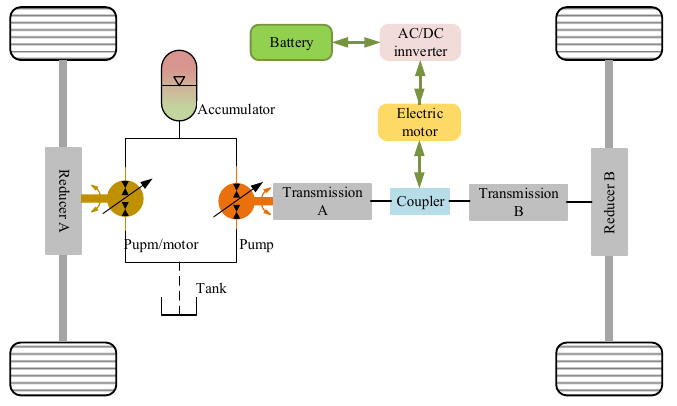
Figure 11. EH3 system in a battery ‐ powered bus [87].